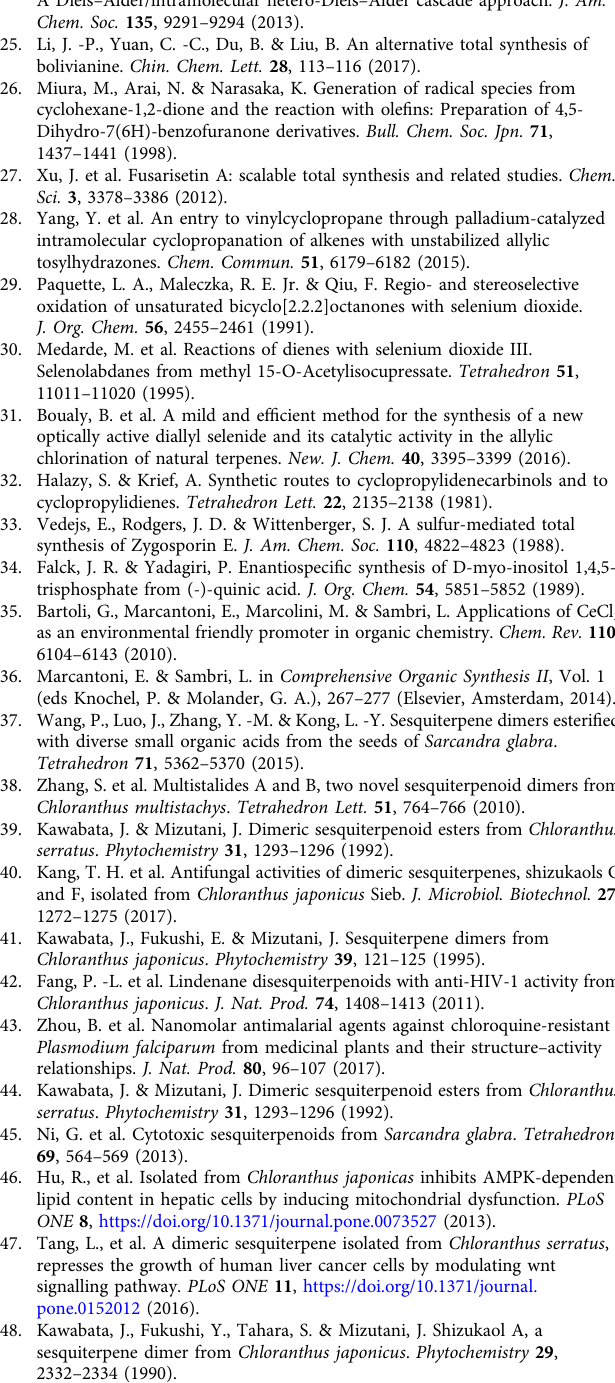
Supplementary Figs. 26 – 94. For the comparison of NMR spectra of the natural products and synthetic products, see Supplementary Tables 1 –